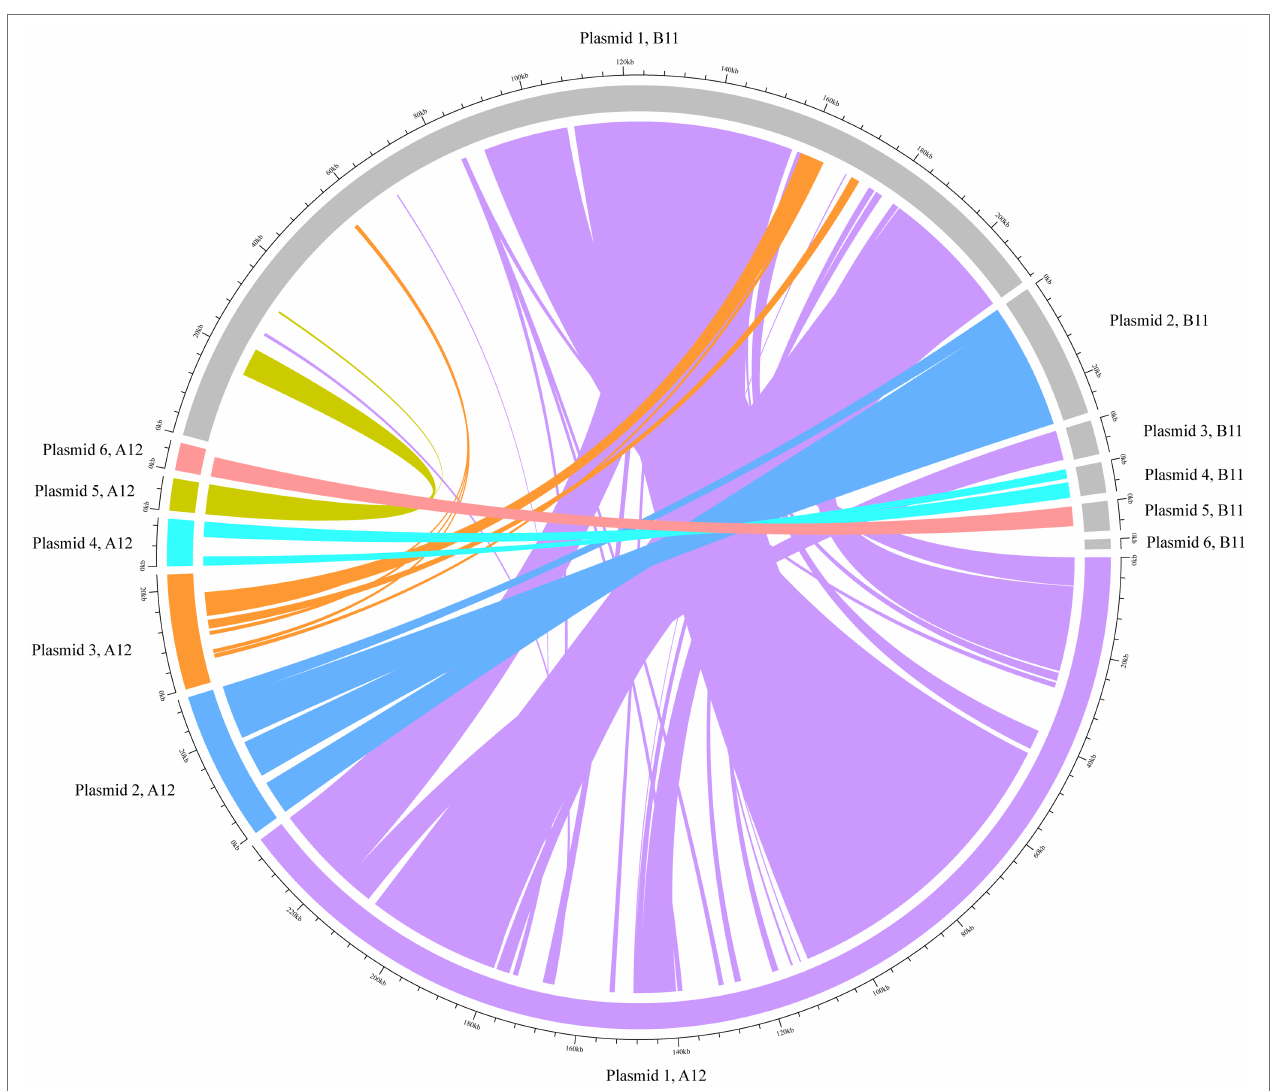
FIGURE 3 | BLAST analysis of the plasmids using Circlize. The plasmid contigs from the hybrid assembles A12 and B11 were used as internal reference for the BLAST analysis. Each of A12 predicted plasmid contigs are presented in colours whilst B11 is depicted in